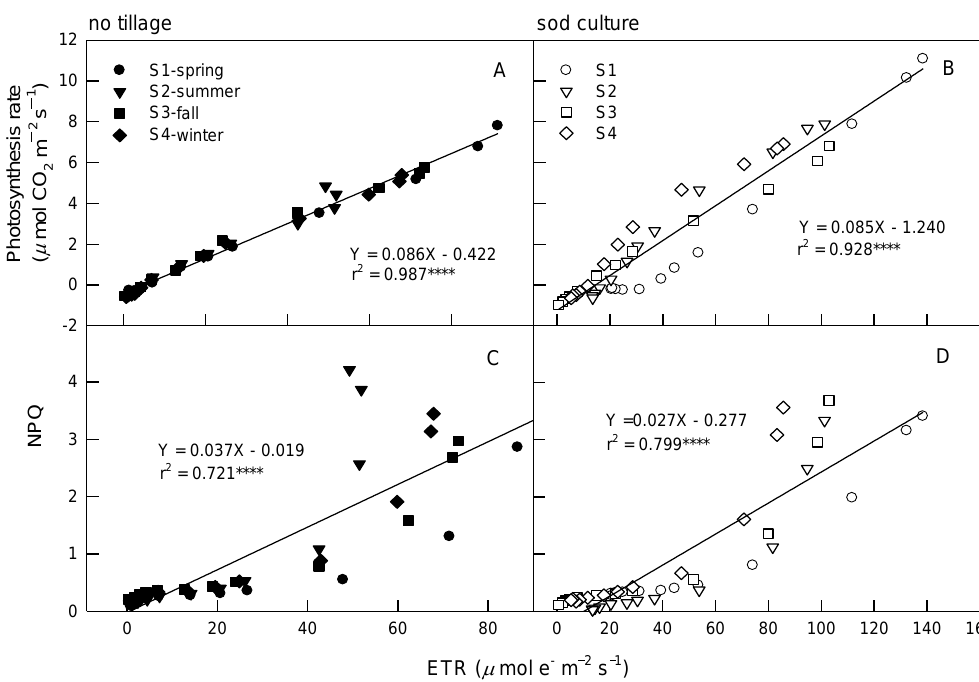
Figure 4. Correlations among ETR and Pn, NPQ of citrus grown in NT (panels A , C ) and SC (panels B , D ) in four seasons (S1–S4 respective to spring, summer, fall, and winter) monitored from June 2019 to May 2020. Plants were subjected to light irradiances at 0, 5, 10, 15, 25, 50, 75, 100, 200, 400, 800, and 1200 μmol m −2 s −1 PPFD for 60 min. Each symbol represents the average of five leaves on one plant, and five plants were randomly selected from tillage and season treatments. Each line represents the time point of 48 values (four seasons multiplied by 12 PPFD) from model validation datasets. Correlation coefficients (r) are calculated and significance ( p ) is at the 0.0001 probability (****)